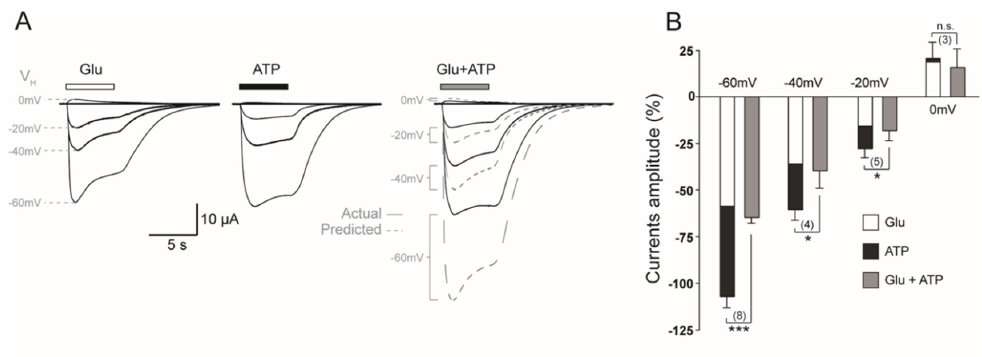
Figure A4. P2X2–NMDAR inhibition is voltage-independent. ( A ) Representative currents recorded at different holding potentials (V H ) from an individual oocyte coexpressing NMDARs and P2X2 responding to 100 µM: Glu (left), ATP (middle), or Glu + ATP (right) are shown. ( B ) Bar graphs comparing the predicted and actual responses obtained at different holding potentials from coapplication of agonists for P2X2 and NMDARs, normalized to the sum of the separate Glu and ATP responses at each potential for each oocyte. The data are expressed as mean ± SEM; Statistical analysis performed using paired t-test * p < 0.05, *** p < 0.001. Parentheses denote number of replicates.